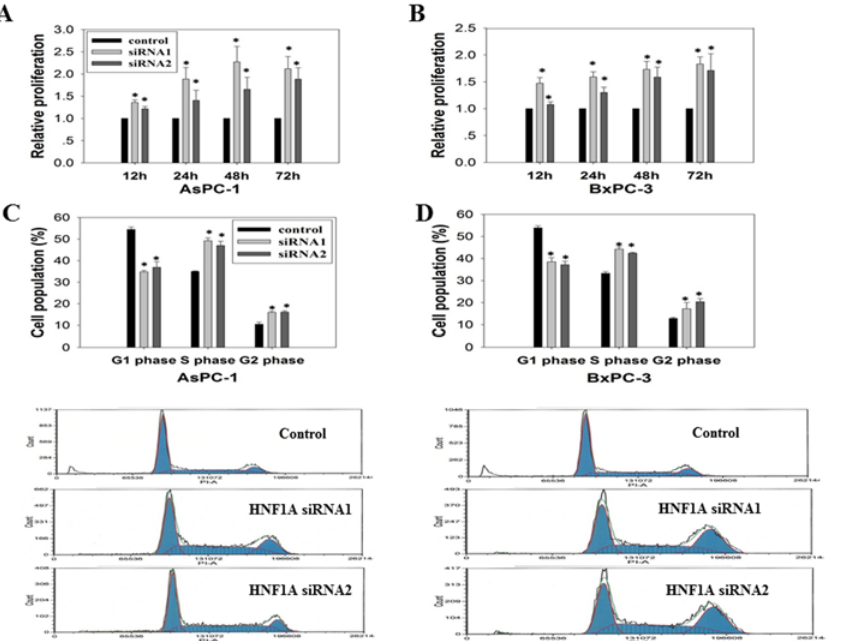
Fig 4. Effect of HNF1A knockdown on cell proliferation and cell cycle. Pancreatic cancer cell lines were transfected with one of the two HNF1A siRNAs or a control siRNA. The proliferation rate of the siRNA- transfected cells was assessed by CellTiter-Glo assay on AsPC-1 (A) and BxPC-3 (B) cells 12 h to 72h after transfection. Cell cycle distribution was determined by Fluorescence-activated cell sorting analysis in AsPC-1 (C) and BxPC-3 (D) cells. Cells were stained with PI, and analyzed for DNA content using flow cytometry 72h following transfections. The populations of cells in G1, S, and G2 phases are characterized by different intensities of PI-A fluorescence and are indicated. Data are shown relative to the control. * P < 0.05 compared with each corresponding